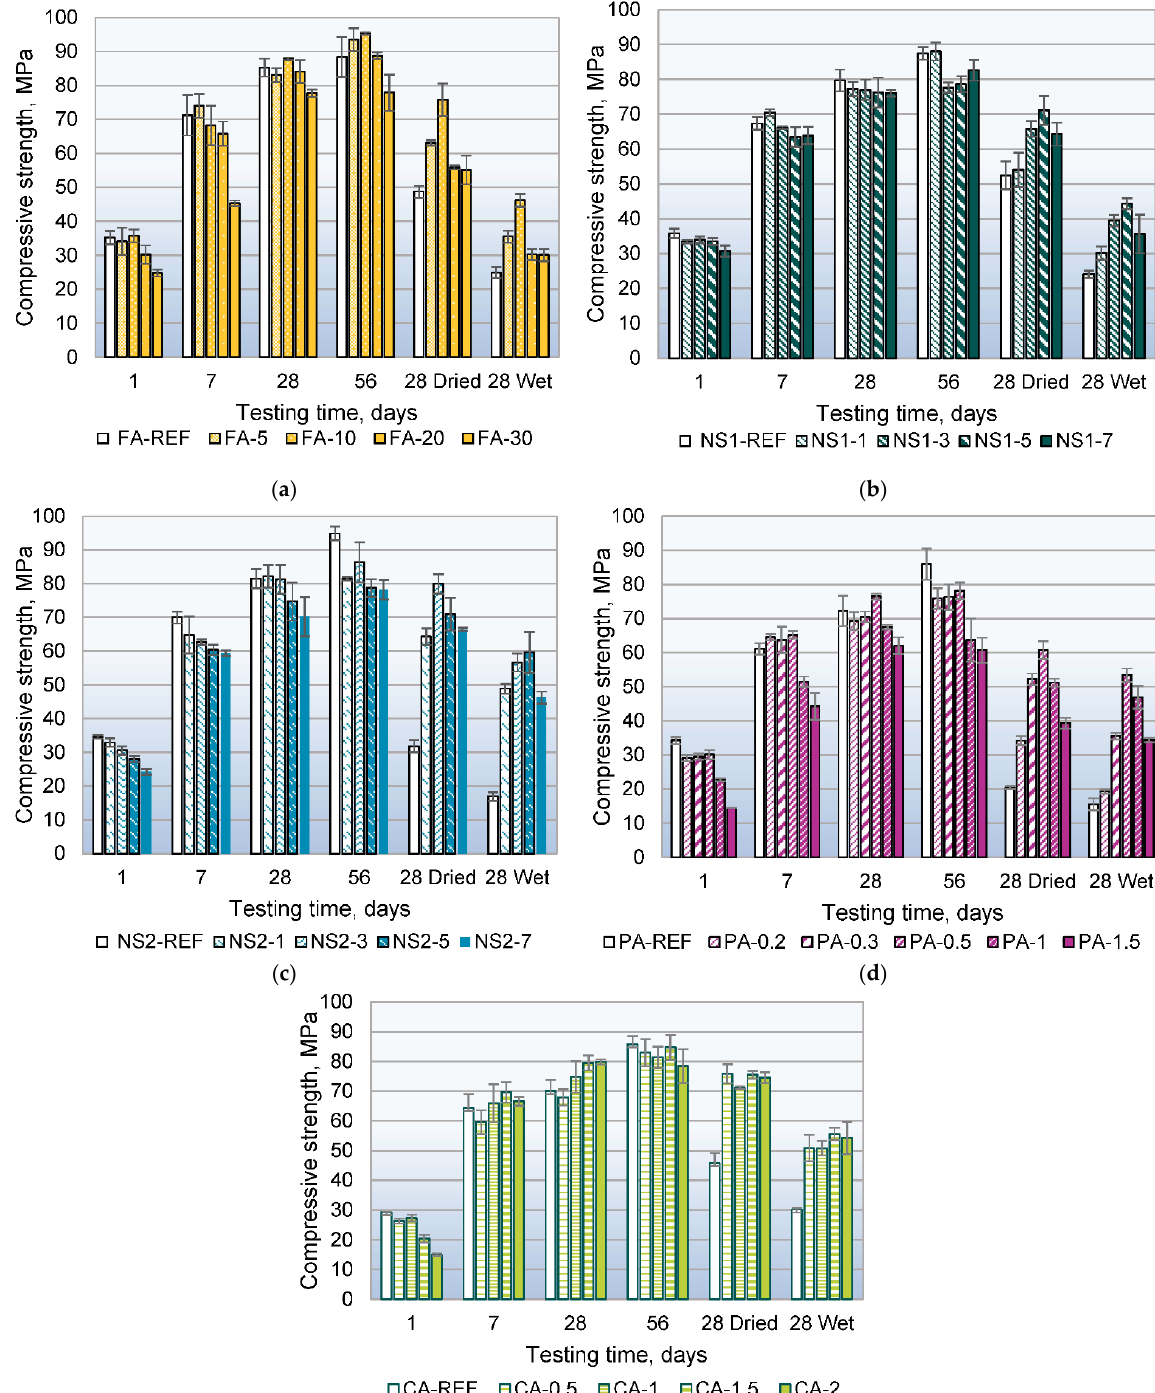
Figure 4. Compressive strength of specimens; dried, wet/water cured; others are air cured. With various additives: ( a ) Fly ash; ( b ) Levasil CB8; ( c ) Levasil CB50; ( d ) Phosphoric acid; ( e ) Citric acid.